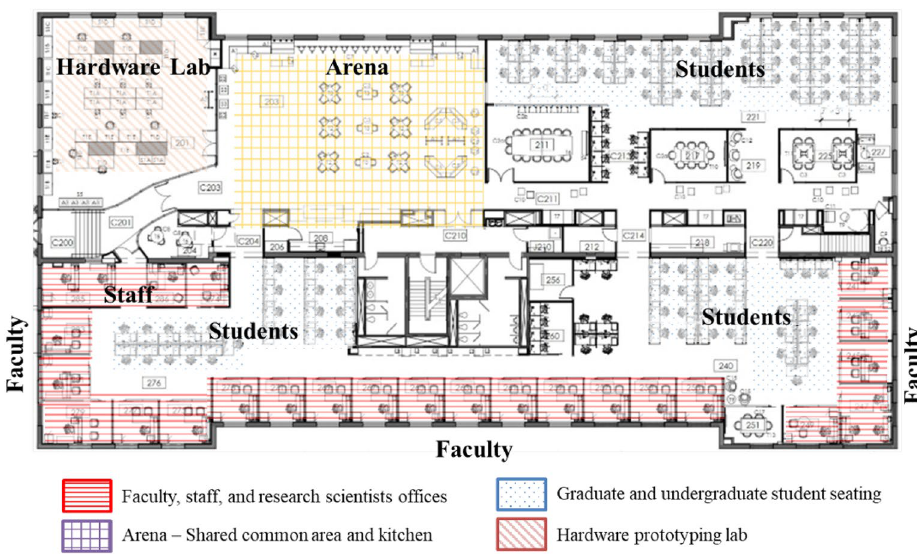
Figure 1. The overview of the smart office building space that participants work